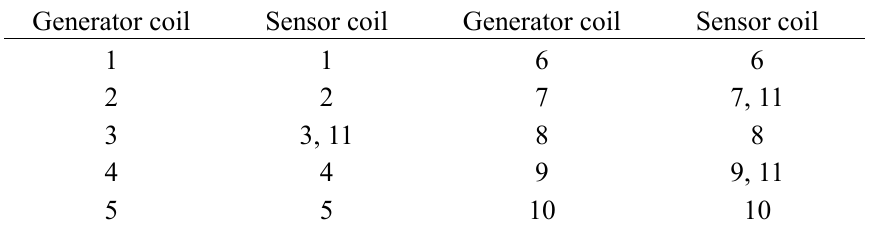
Table 5. The mapping pairs of the generator and sensor